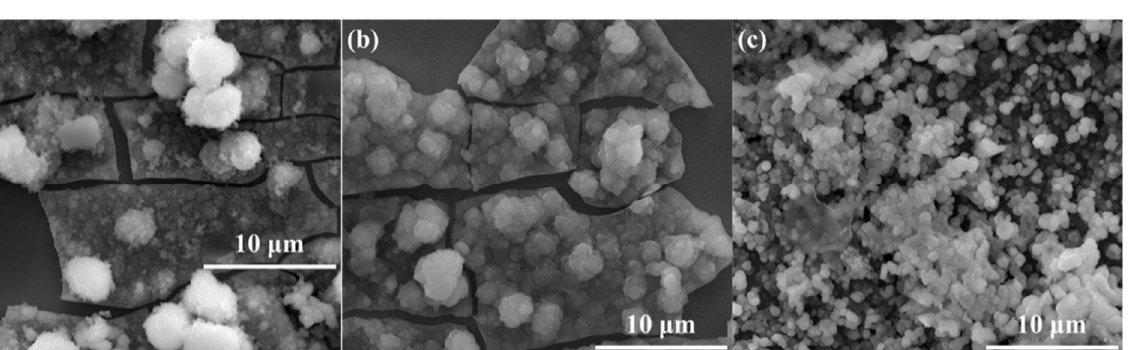
Figure 8. The EDS analysis of 304 stainless ‐ steel samples after being treated by polarization meas ‐ urements in different solutions and a 4 week immersion test in SG + Na 2 SeO 3 solution: ( a ) SG + CaCl 2 solution; ( b ) SG + Na 2 CO 3 solution; ( c ) SG + Na 2 SiO 3 solution.